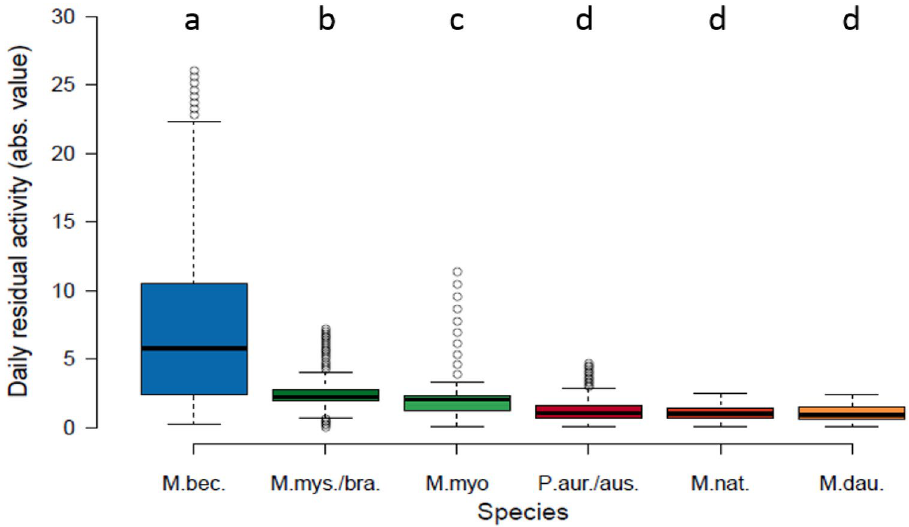
Figure 2. Species in order of decreasing median of absolute values of residual activity from zero (= increasing dependency from ambient weather). M.bec. = Myotis bechsteinii , M.mys./bra. = Myotis mystacinus/brandtii ,M. myo. = Myotis myotis , P.aur./aust. = Plecotus auritus/austriacus , M.nat. = Myotis nattereri , M.dau. = Myotis daubentonii ; The letters indicate species groups of non significant pairwise post-hoc tests with Bonferroni correction for multiple tests ( p < 0.05).